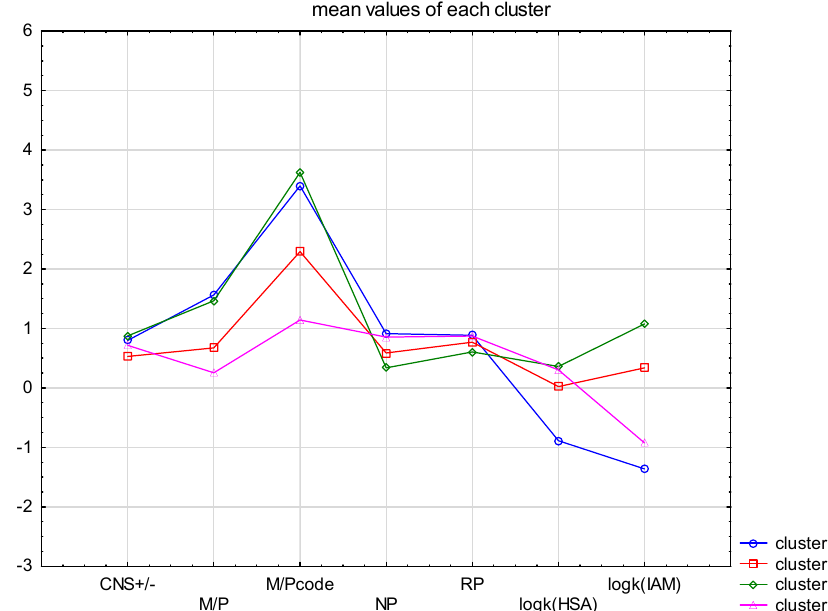
Figure 5. Mean value graph of the chromatographic data for four clusters: CNS+, CNS − , M/P+ and M/P − .